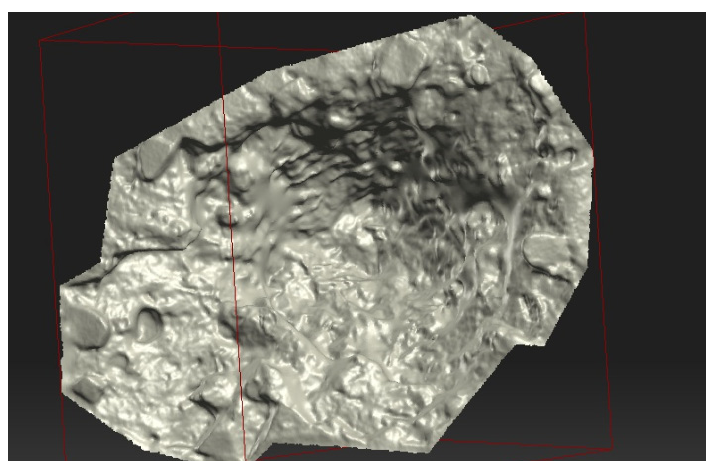
Figure 9. Multiple scans.